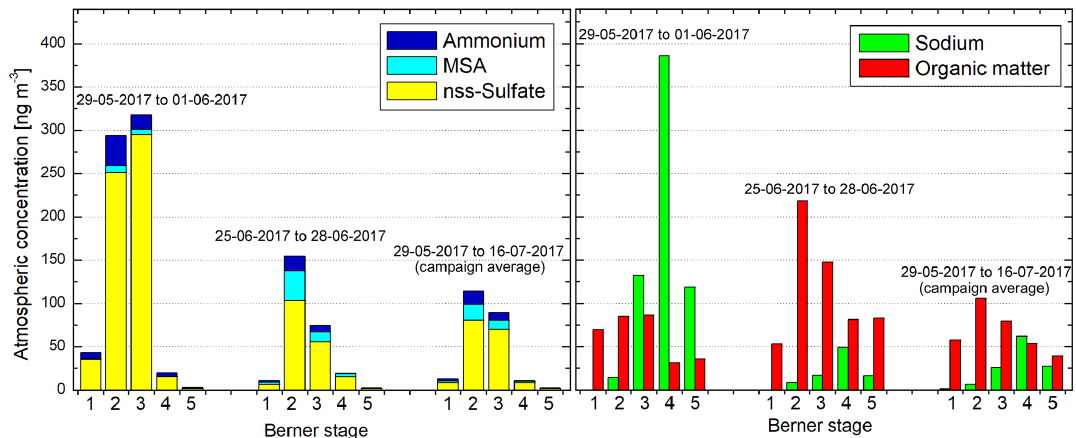
Figure 4. Size-resolved atmospheric concentrations for ammonium, MSA, nss-sulfate, sodium, and OM for two sampling periods and the whole campaign average. Stages 1, 2, 3, 4, and 5 correspond to aerodynamic particle diameter ranges of 0.05–0.14, 0.14–0.42, 0.42–1.2, 1.2–3.5, and 3.5–10µm,